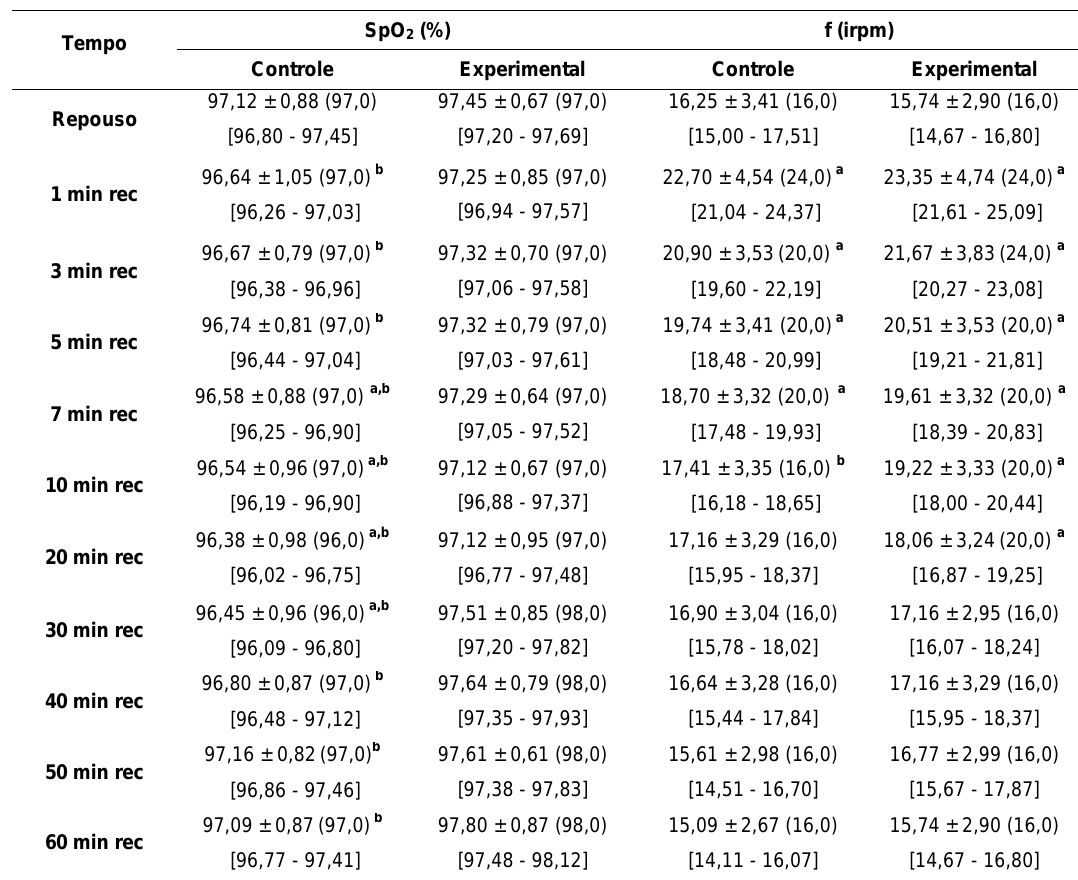
Tabela 5- Valores médios, seguidos dos seus respectivos desvios-padrão, mediana e intervalo de